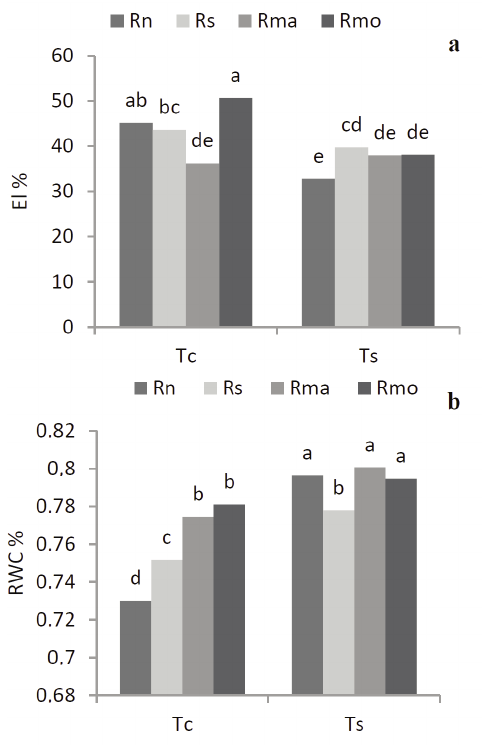
Fig. 9 ­ The interaction effect of temperature and cucumber grafting on El (a) and RWC (b) Tc= optimum temperature, Ts= low temperature, Rn = nongrafted ( Cucumis sativus var. DavosII); Rs= (self grafted); Rma= Cucurbita maxima , Rmo= Momordica charantia .